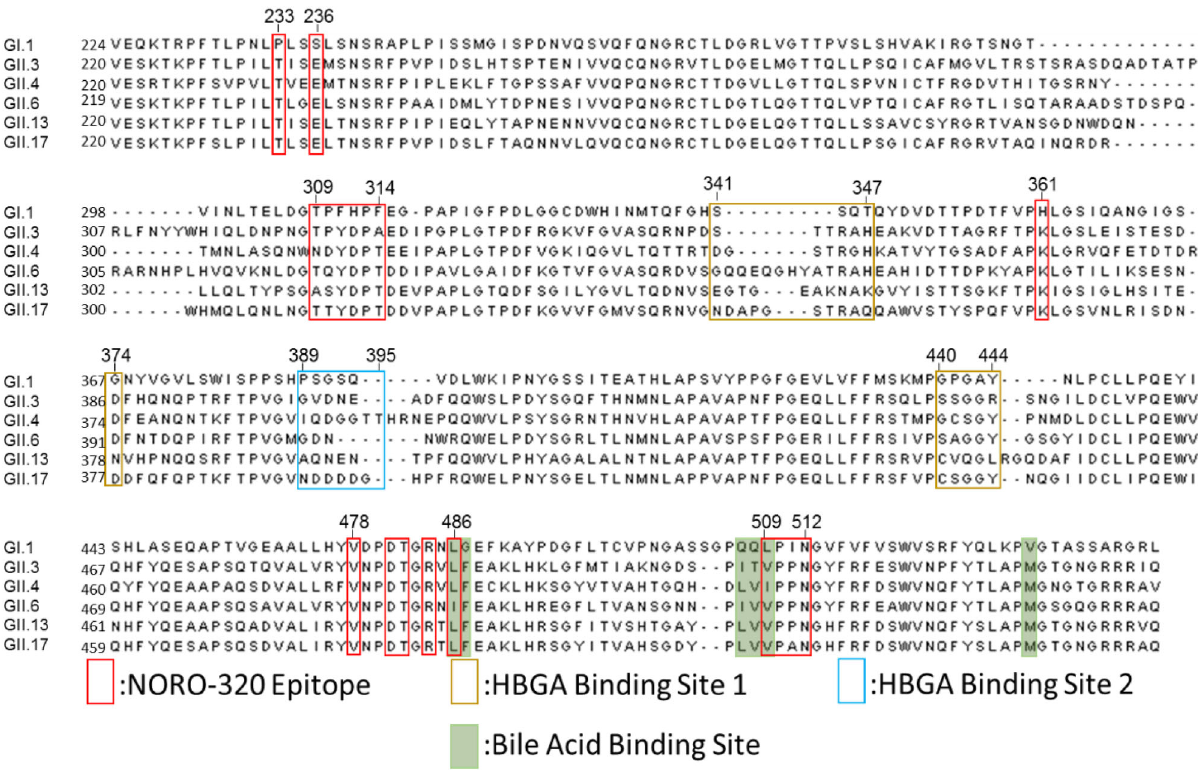
Fig. 8 Amino acid sequence alignment of the protruding domain of GI.1, GII.3, GII.4, GII.13, and GII.17 strains of HuNoV. The protruding domain amino acid sequences of GII.3, GII.4, GII.13, and GII.17, the GII strains tested for which NORO-320 exhibited reactivity, and GI.1 are aligned. The 18 residues identi fi ed on GII.4 that interact with the highly cross-reactive mAb NORO-320 are boxed in red. The residues previously reported to be involved in GII.4 HBGA binding 55 are boxed in gold and blue. The recently identi fi ed low-af fi nity bile acid-binding site 56 is boxed in